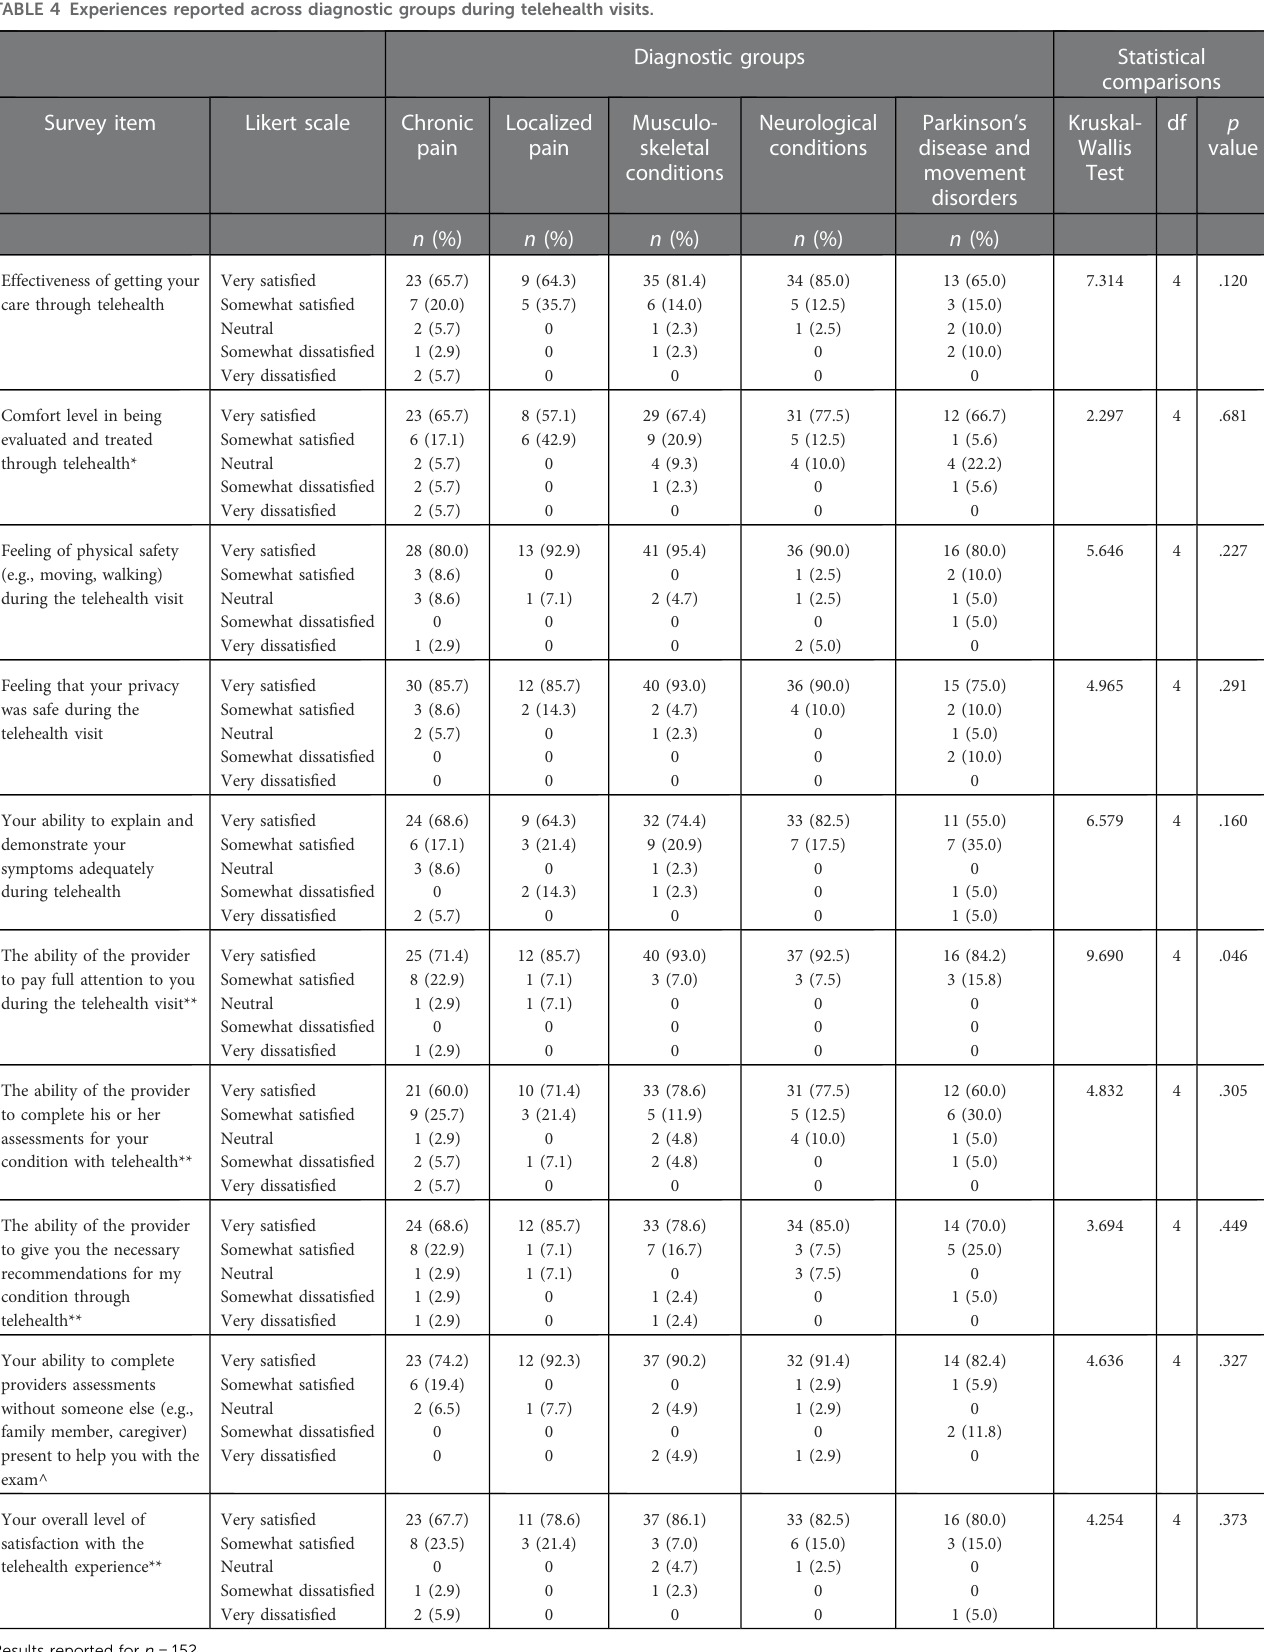
TABLE 4 Experiences reported across diagnostic groups during telehealth